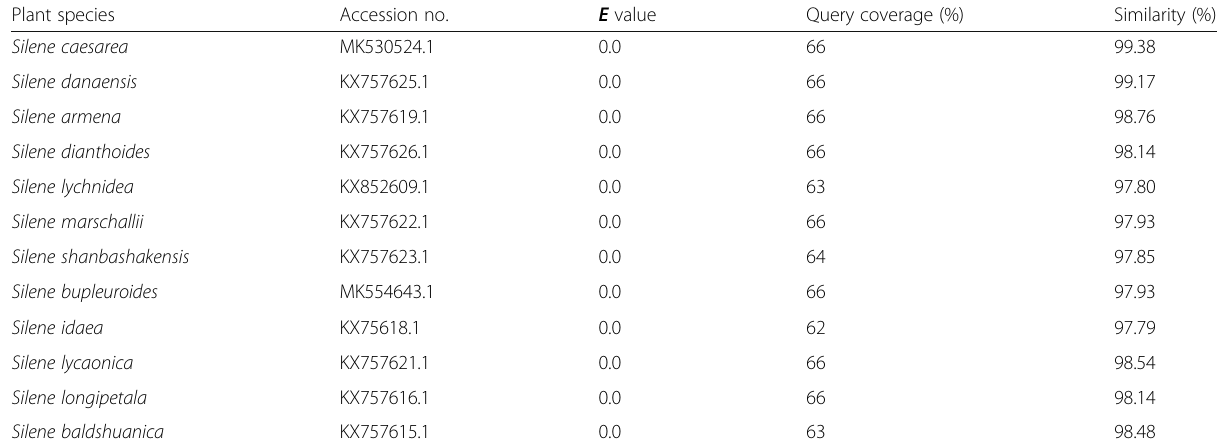
Table 4 DNA barcode of internal transcribed spacer ( ITS ) downloaded from GenBank database including plant species with similarity percentage of more than 97.78%